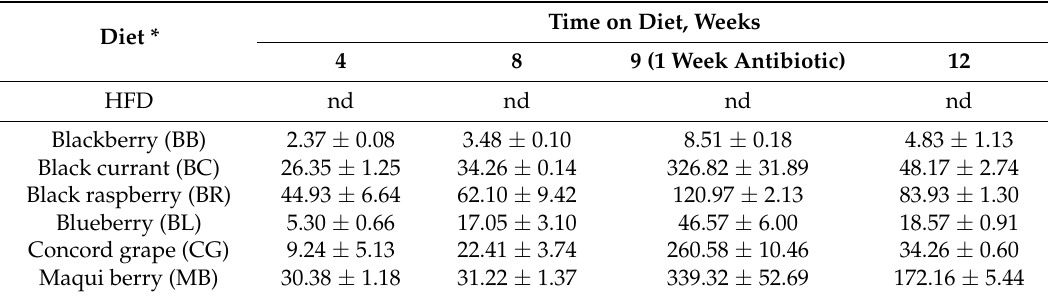
Table 3. Total anthocyanins recovered from feces ( µ g/g